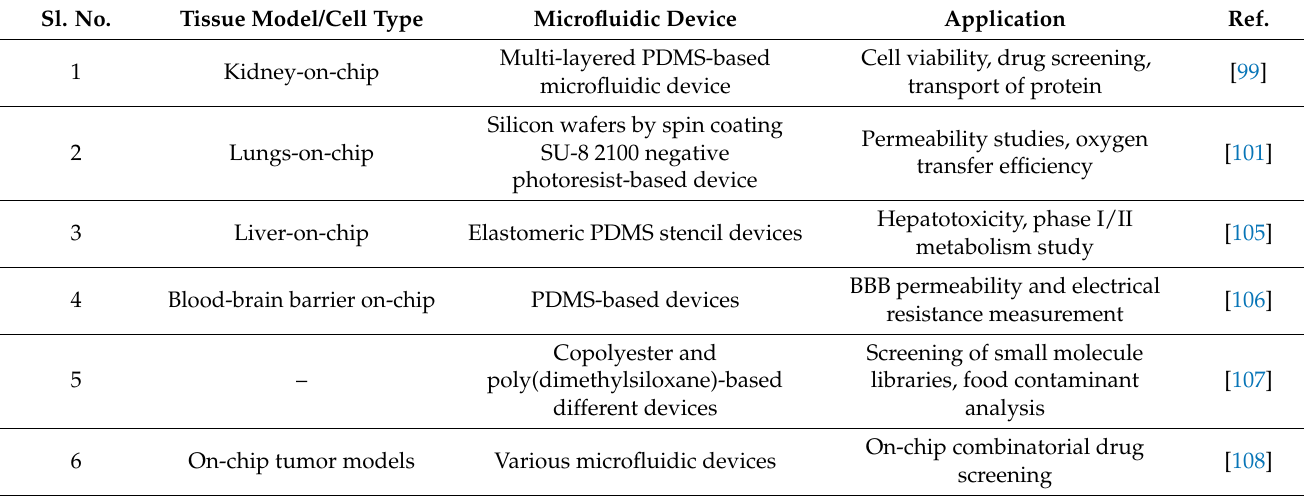
Table 4. Applications of microfluidic devices in drug